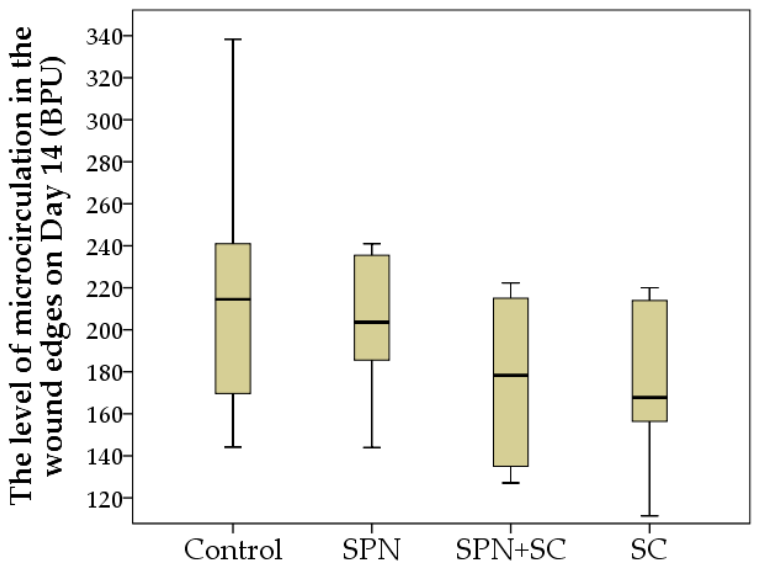
Figure 9. The level of microhemocirculation in the wound edges in different groups on day 14 (BPU). Notes: Data are presented as median and interquartile range. Table 1. The content of resident and non-resident cells in the center and edges of wounds of different groups on day 3 (%). Residents on Day 3 Non-Residents on Day 3 Groups Edge 1 Center Edge 2 Edge 1 Center Edge 2 Control 21.8 ± 4.6